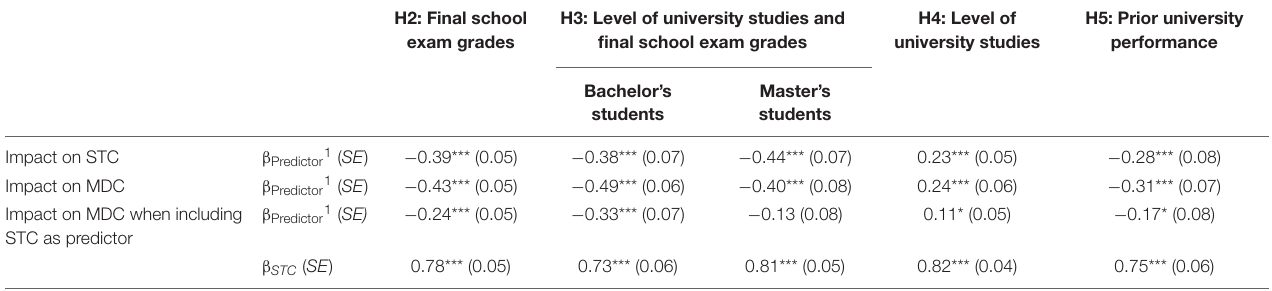
TABLE 5 | Standardized effect sizes of the impact of the level of university studies, final school exam grades and prior university performance and STC on MDC per hypothesis.